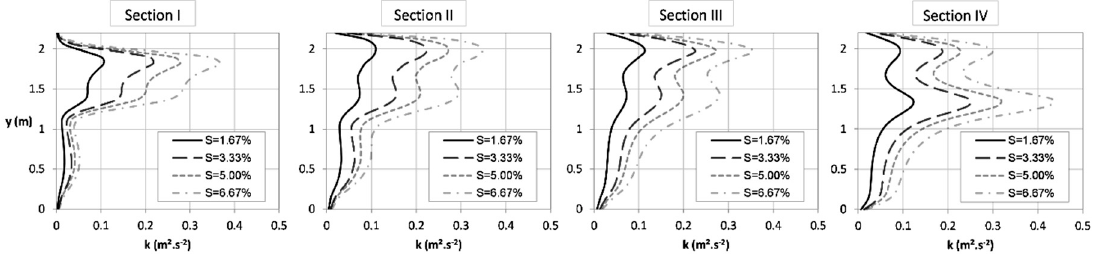
Figure 6. Turbulence kinetic energy, k, in four cross sections I, II, III and IV (Figure 3), for the plane parallel to the bottom at z/h = 0.4, for the four slopes tested in design D1.